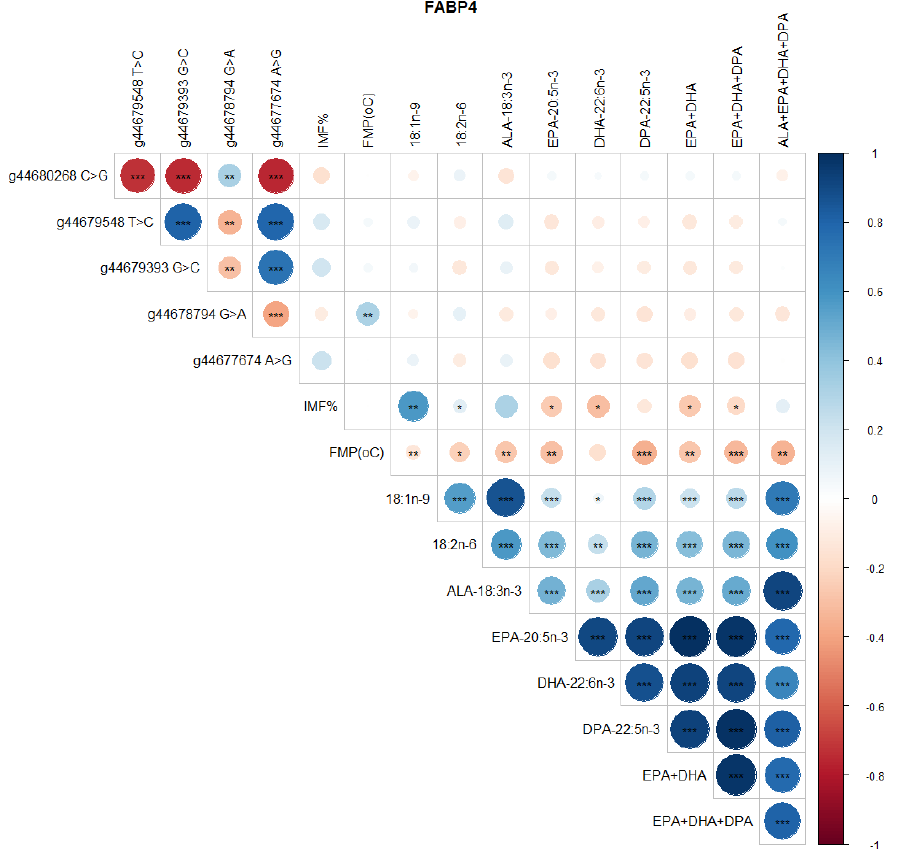
Figure 6. Spearman’s correlations between FABP4 gene SNP loci, IMF, FMP, and fatty acid profiles of Bowen Genetics Forest Pastoral Angus, Hereford, and Wagyu beef cattle breeds. (* p < 0.05, ** p < 0.01; *** p < 0.001). Dark blue indicates a strong positive relationship, and dark red shows a strong negative relationship. Table 5. Descriptive summaries of the associations between SCD SNP locus g.21267406 T>C and genotypes with intramuscular fat (IMF), fat melting point (FMP), and fatty acid composition in Bowen Genetics Forest Pastoral Angus, Hereford, and Wagyu beef cattle presented as median (inter- quartile